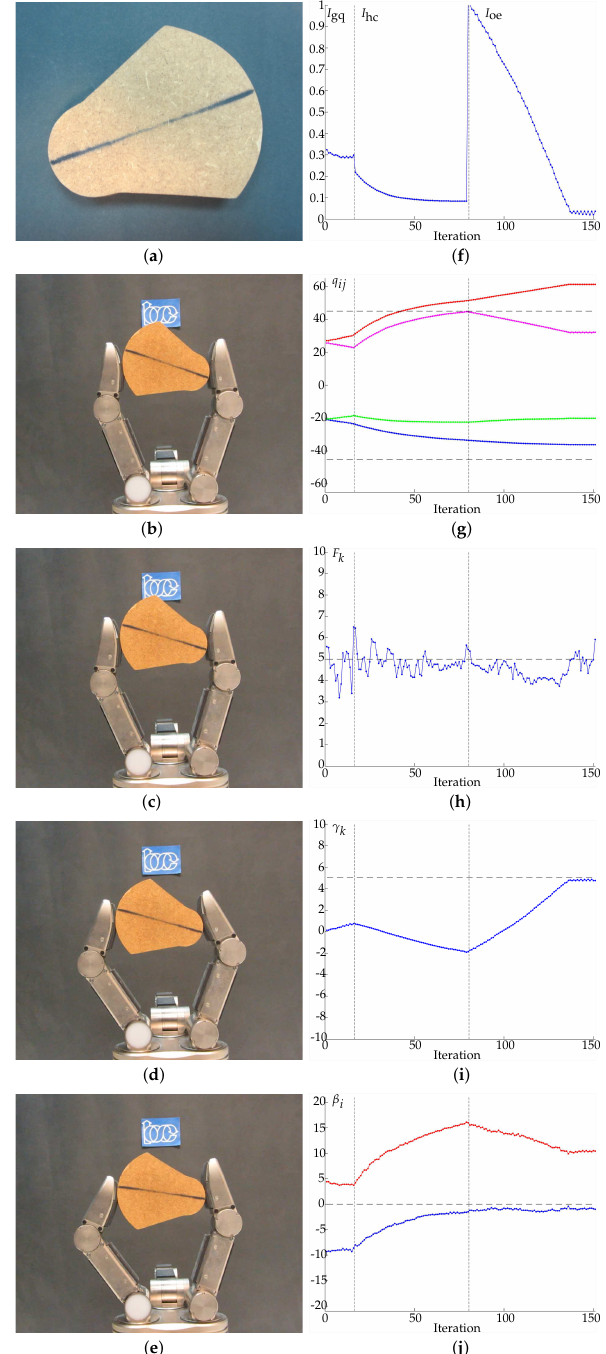
Figure 12. Example 2. ( a ) Manipulated object. ( b ) Initial grasp. ( c ) Hand configuration after optimizing I gq . ( d ) Hand configuration after optimizing I hc . ( e ) Hand configuration after optimizing I oe . ( f ) Evolution of the quality indexes. The manipulations improving I gq , I hc and I oe ended after 1.171 s and 16 iterations, 4.687 s and 62 iterations and 9.709 s and 71 iterations, respectively. ( g ) Evolution of the joints values in degrees, q 11 in blue, q 12 in red, q 21 in green, q 22 in magenta. ( h ) Average force F k in Newtons, the dashed line indicates F d . ( i ) Evolution of the object orientation in degrees. ( j ) Angles β i in degrees, β 1 in blue and β 2 in red (the dashed line indicates the optimal value of β i